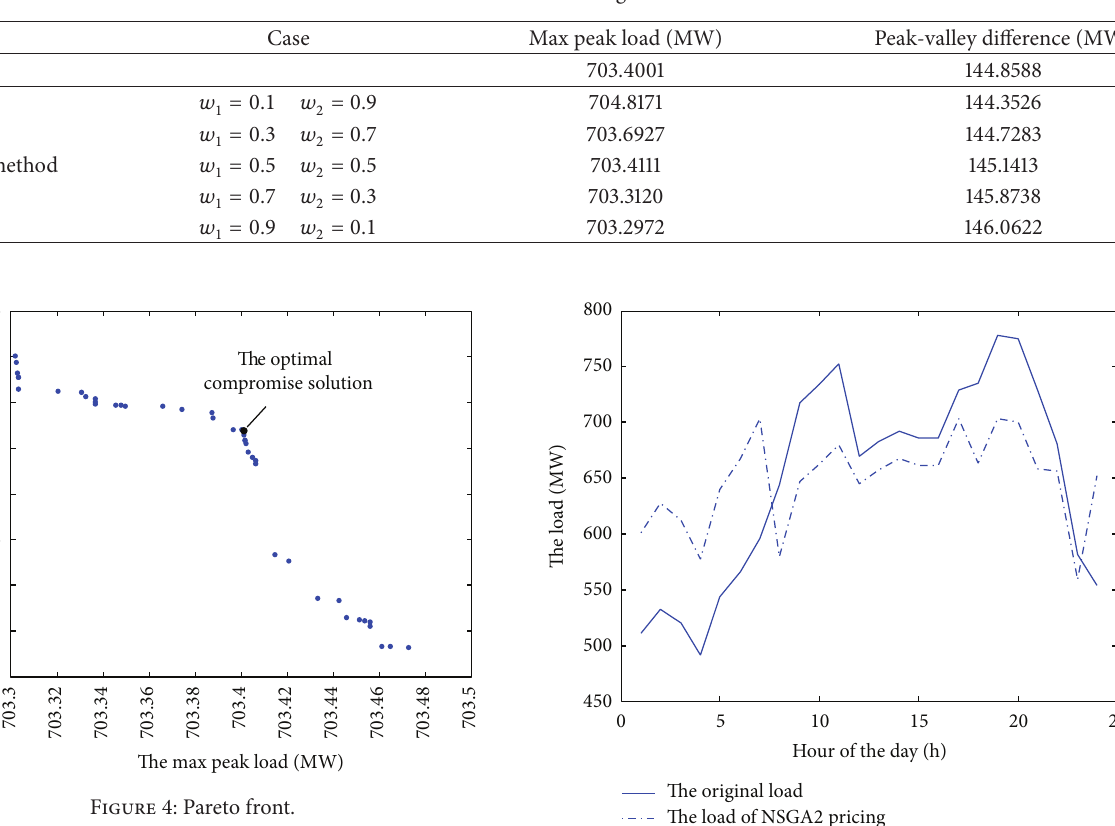
Table 5: Contrast of NSGA2 and weighted method.